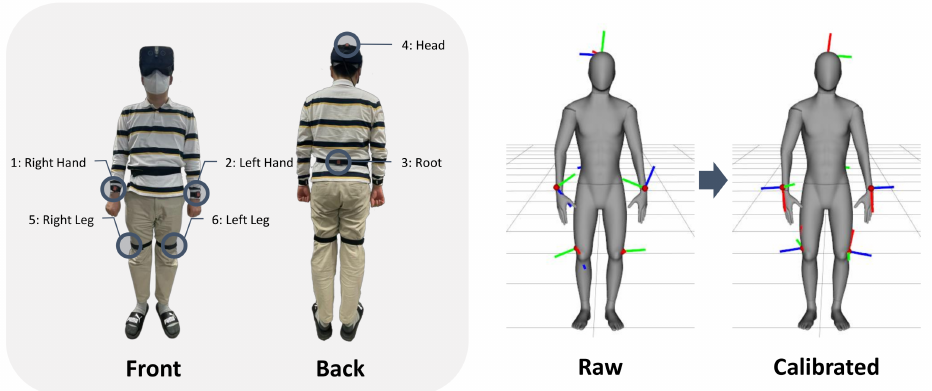
Figure 5. The IMU placement and calibration: ( Left ) the placement of the six IMUs that were attached to the body: right hand, left hand, pelvis (root), head, right leg, and left leg; ( Right ) the results of the IMU sensor calibration to the body-centric